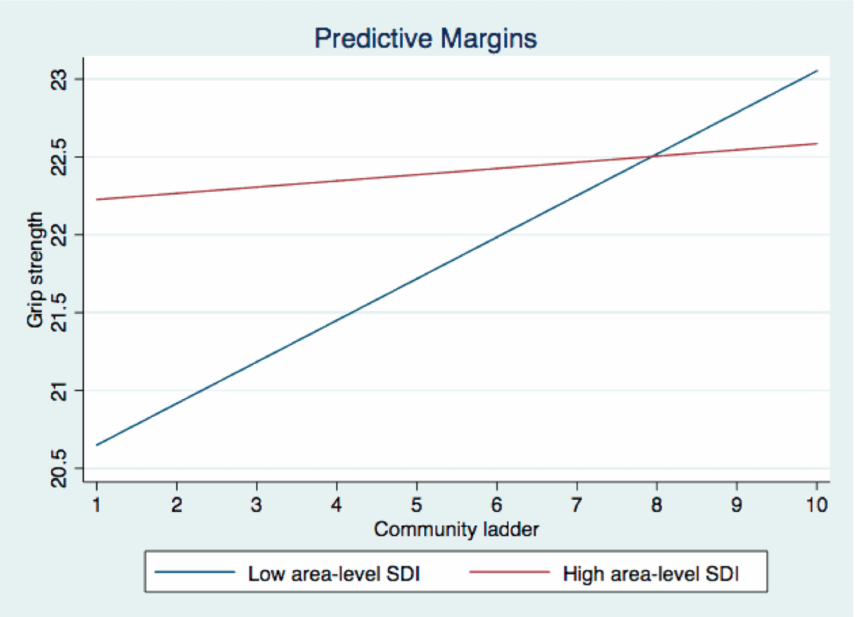
Figure 3. Interactive effect between SES ladder-community and SDI on grip strength among